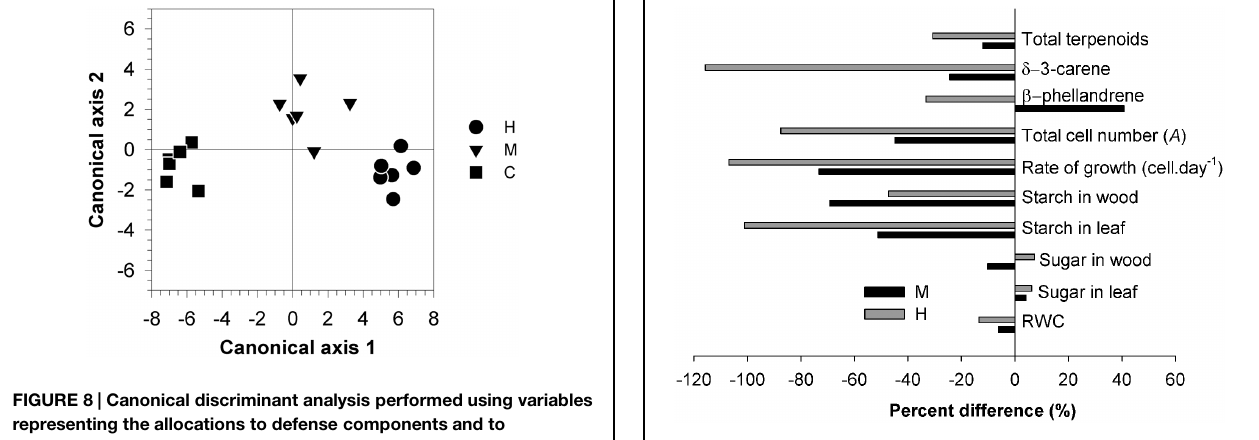
FIGURE 9 | Percentage difference between values measured in the C-trees and those measured in the M- and H-trees. of a carbon imbalance (i.e., a quasi-absence of carbon